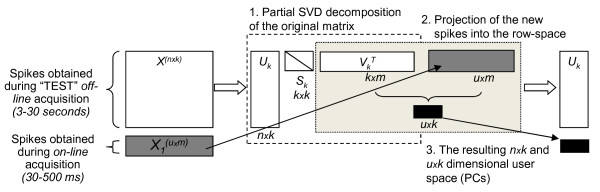
Schematic diagram of the Partial SVD application for extraction of PCs. White elements represent standard Partial SVD decomposition used in offline or “TEST” clustering. Grey elements show an online classification strategy in which the new SVD can be expressed as a product of old subspaces. These are small-matrix operations, and therefore rapid.